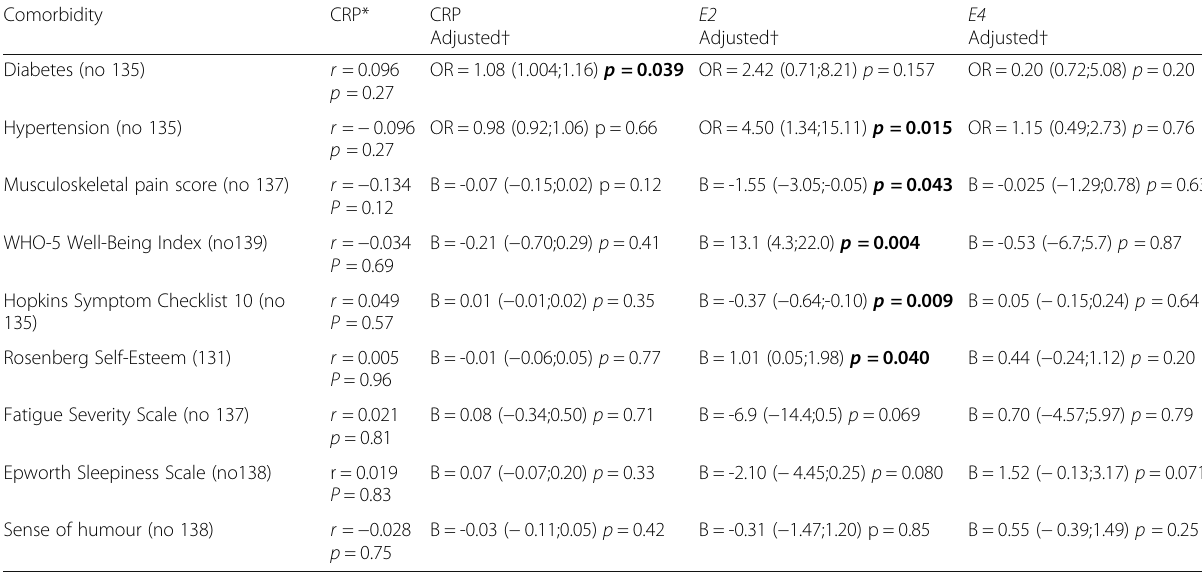
Table 4 Associations between comorbidity and CRP